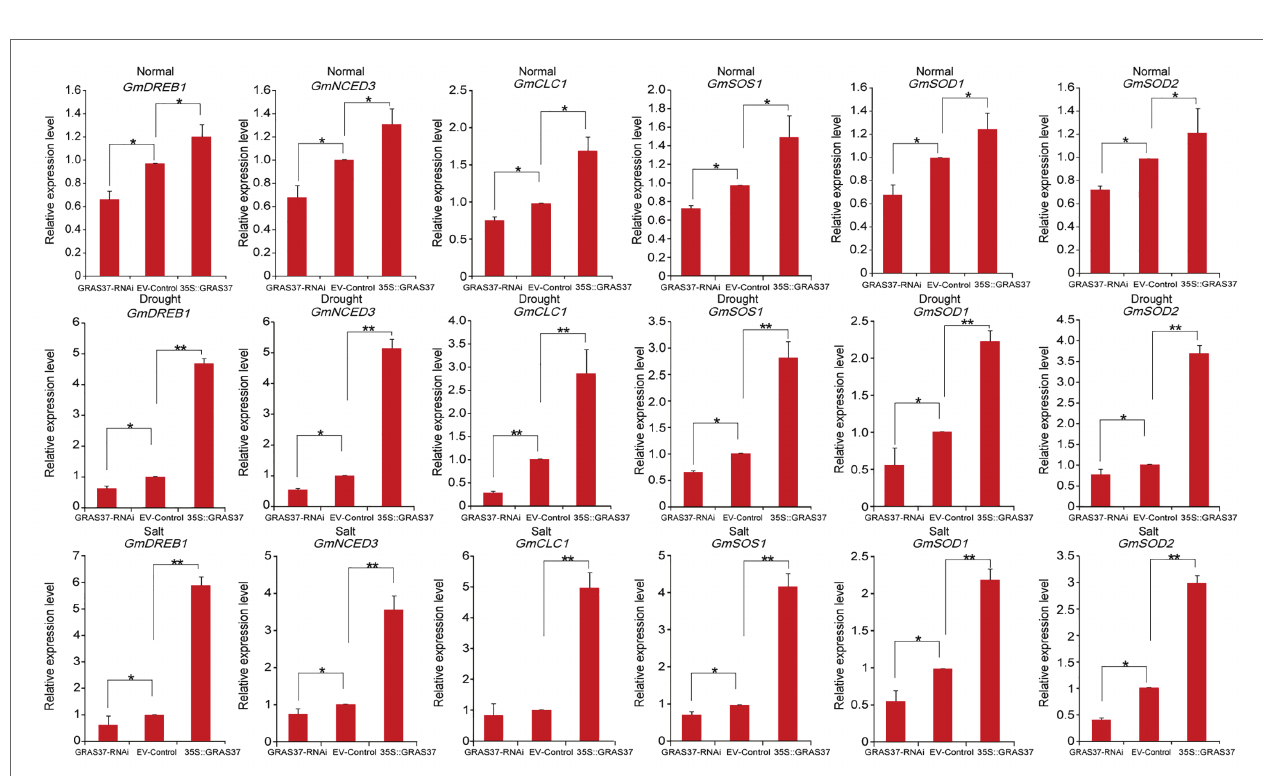
FIGURE 13 | Expression levels of six stress-responsive genes in transgenic GmGRAS37 soybean hairy root plants under normal conditions, drought stress, and 250 mM NaCl treatment determined by qRT-PCR. Vertical bars indicate ±SD of three replicates. ∗ ( p < 0.05) and ∗∗ ( p < 0.01) indicate significant differences determined by Student’s t